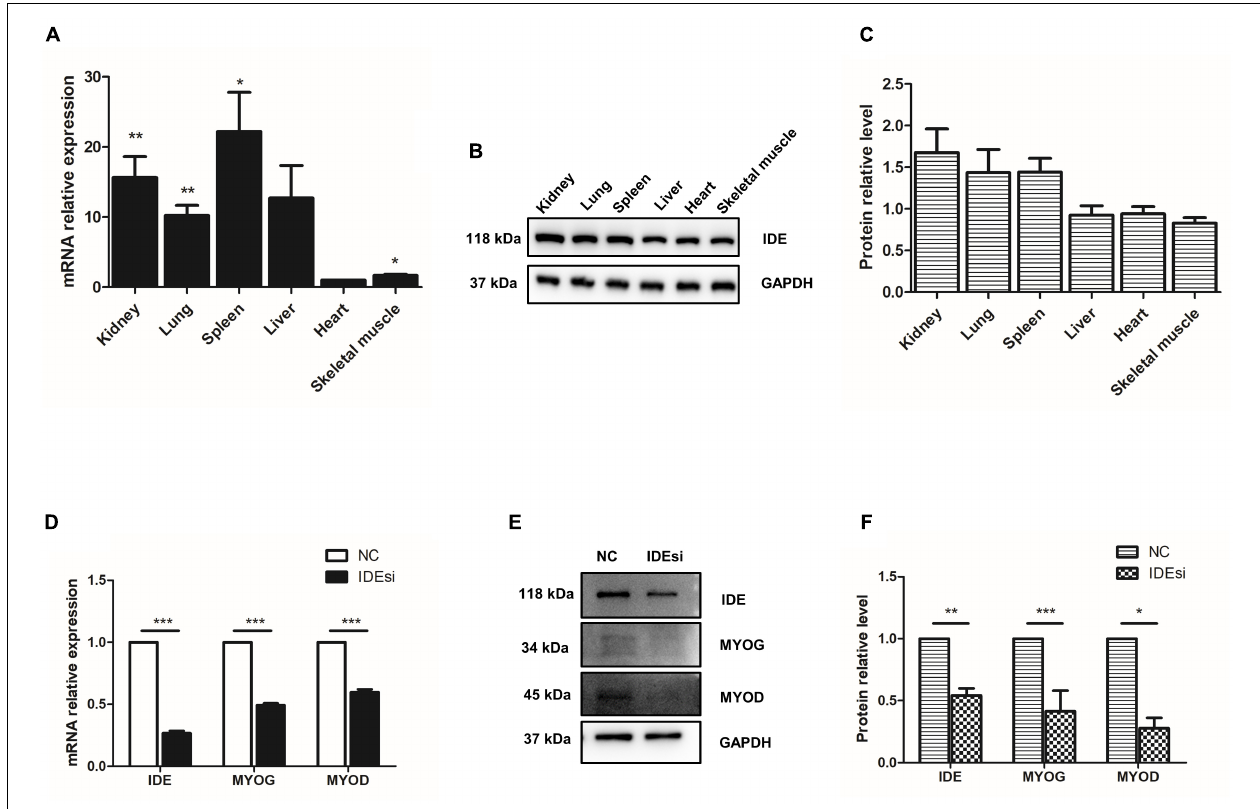
FIGURE 1 | Insulin-degrading enzyme is widely expressed in pig tissues and its knockdown reduces the expression of MYOD and MYOG . (A–C) RT-qPCR assay (A) and western blotting analysis (B,C) indicate that IDE is widely expressed in kidney, lung, spleen, liver, heart, and skeletal muscle of pigs. (D–F) IDE knockdown reduces the expression of IDE , MYOD , and MYOG at both mRNA (D) and protein level (E,F) with RT-qPCR assay and western blotting analysis, respectively. * P < 0.05, ** P < 0.01, and *** P <